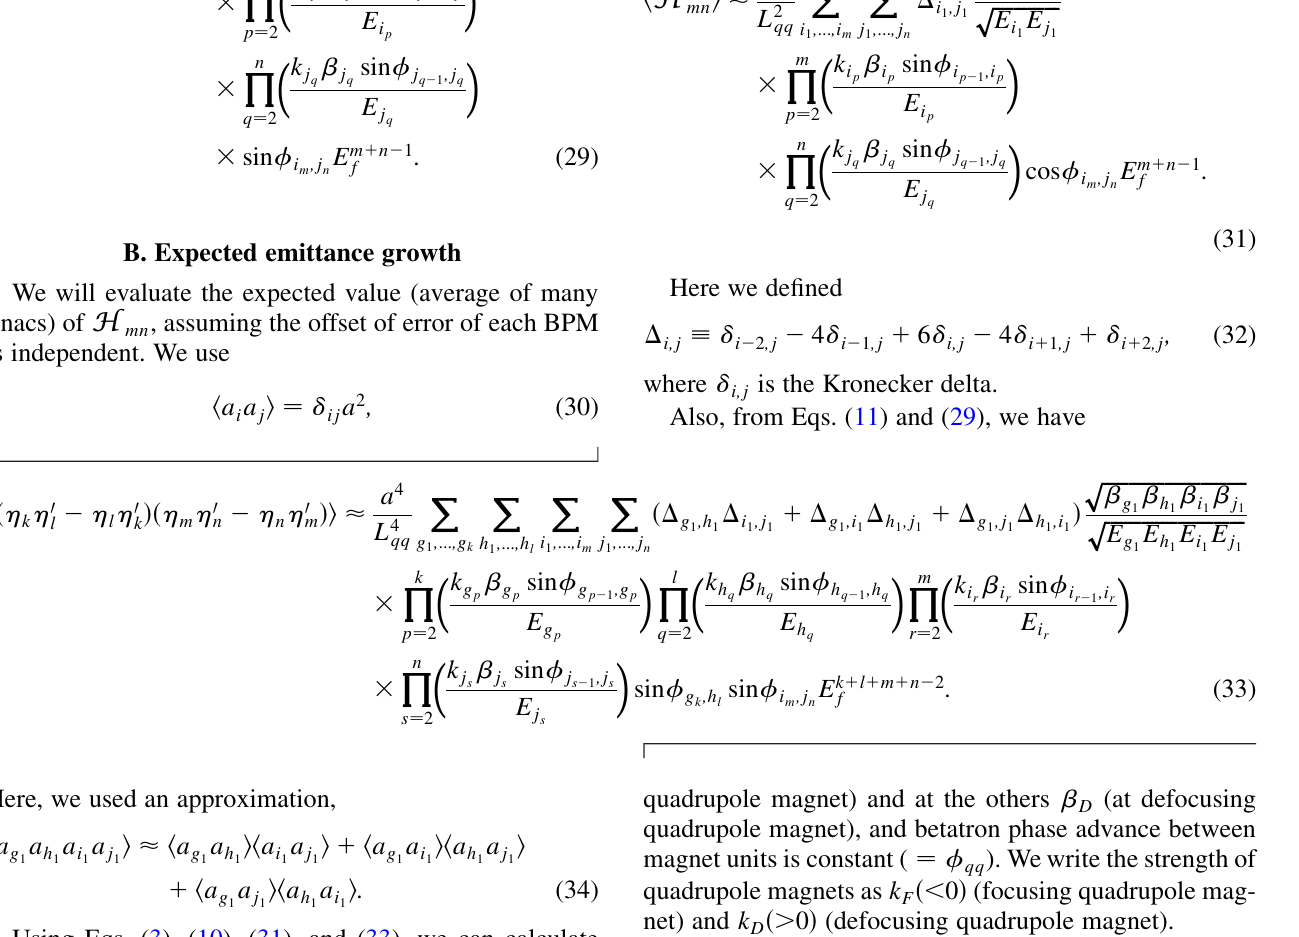
(cid:6) (cid:6) i 1 j 1 ffiffiffiffiffiffiffiffiffiffiffiffiffi E E i 1 j 1